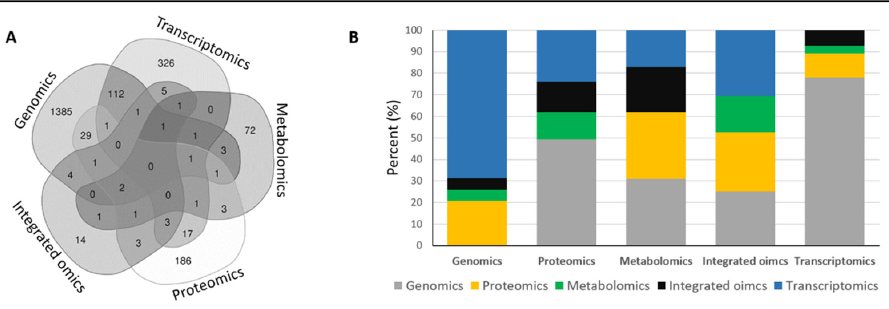
Figure 2. Co-dependency of omics platforms in radiation biology: ( A ) studies shared amongst different omics platforms used in radiation research from the year 2000 onwards; ( B ) the studies applied one type of omics as the main platform and additional accompanied methods. Searches were performed in the NCBI Pubmed database, and reviews were excluded.